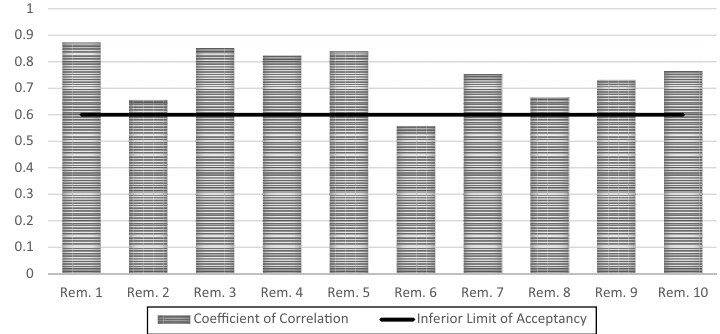
Figure 1. Coef fi cient of correlation between types of